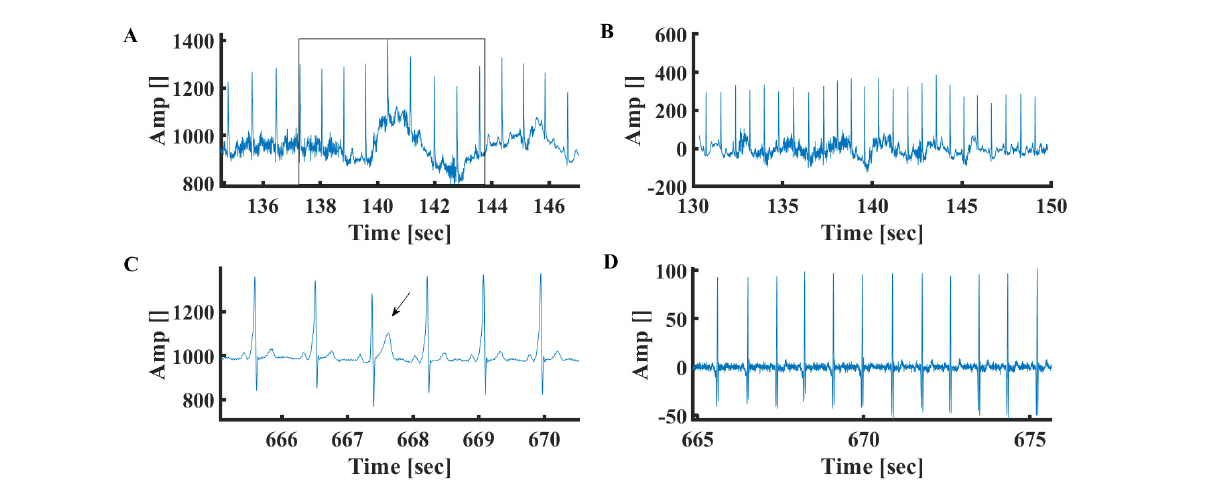
Figure 4. Representative example of (A) slow respiratory oscillation noise (the box represents a breathing cycle) and (B) ECG signal after respiratory oscillation filtering. Data from MIT-BIH Arrhythmia Physionet database #101. Repetitive examples of (C) enlarged T wave and (D) ECG signal after enlarged T filtering. Data from MIT-BIH Arrhythmia Database